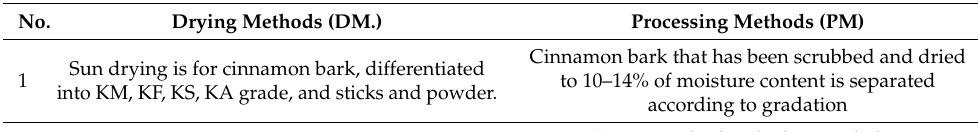
Cinnamon bark, separated according to gradation, is then cut into according to buyer preferences. Packing is done using a gunny sack.